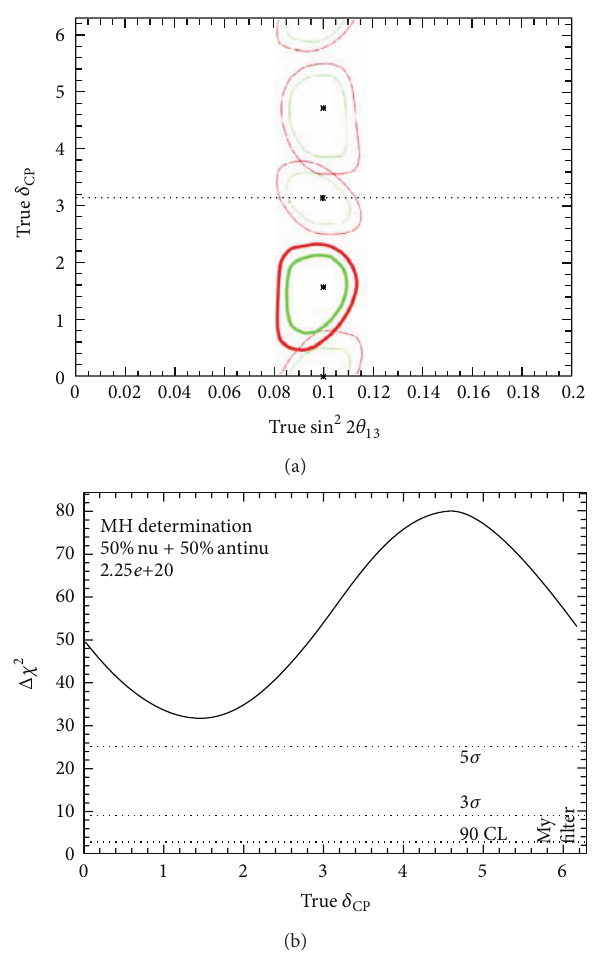
Figure 26: (a) The PMT support structure is optically shielded from -sin 2 2𝜃 13 the tank walls; (b) each optical module contains a fully enclosed CP PMT equipped with a Winston cone. Nonscintillating mineral oil is added to prevent gammas emerging from the PMTs from reaching the scintillator